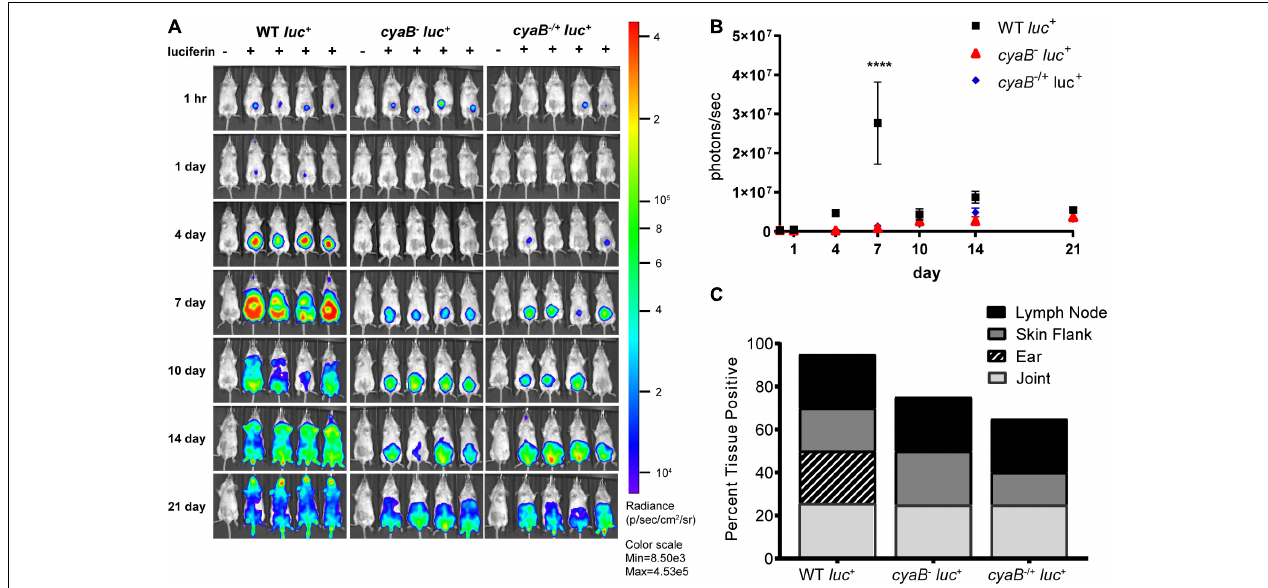
FIGURE 8 | Bioluminescent cyaB − has attenuated infection and dissemination. (A) Bioluminescent Borrelia burgdorferi is temporal and spatial tracked during infection of Balb/c mice with 10 5 WT, cyaB − , or c- cyaB -SR0623. Mice were imaged at 1 h and 1, 4, 7, 10, 14, and 21 dpi. The mouse in the first position of the image, indicated by (-), did not receive D-luciferin to serve as a background control. n of 5 for each infection group. (B) The bioluminescence of four mice was quantitated and averaged. Statistical analysis was performed using two-way ANOVA with Tukey correction relative to WT, **** p -value < 0.0001. (C) The percentage of tissues positive for B. burgdorferi at 21 dpi, grown in BSKII +